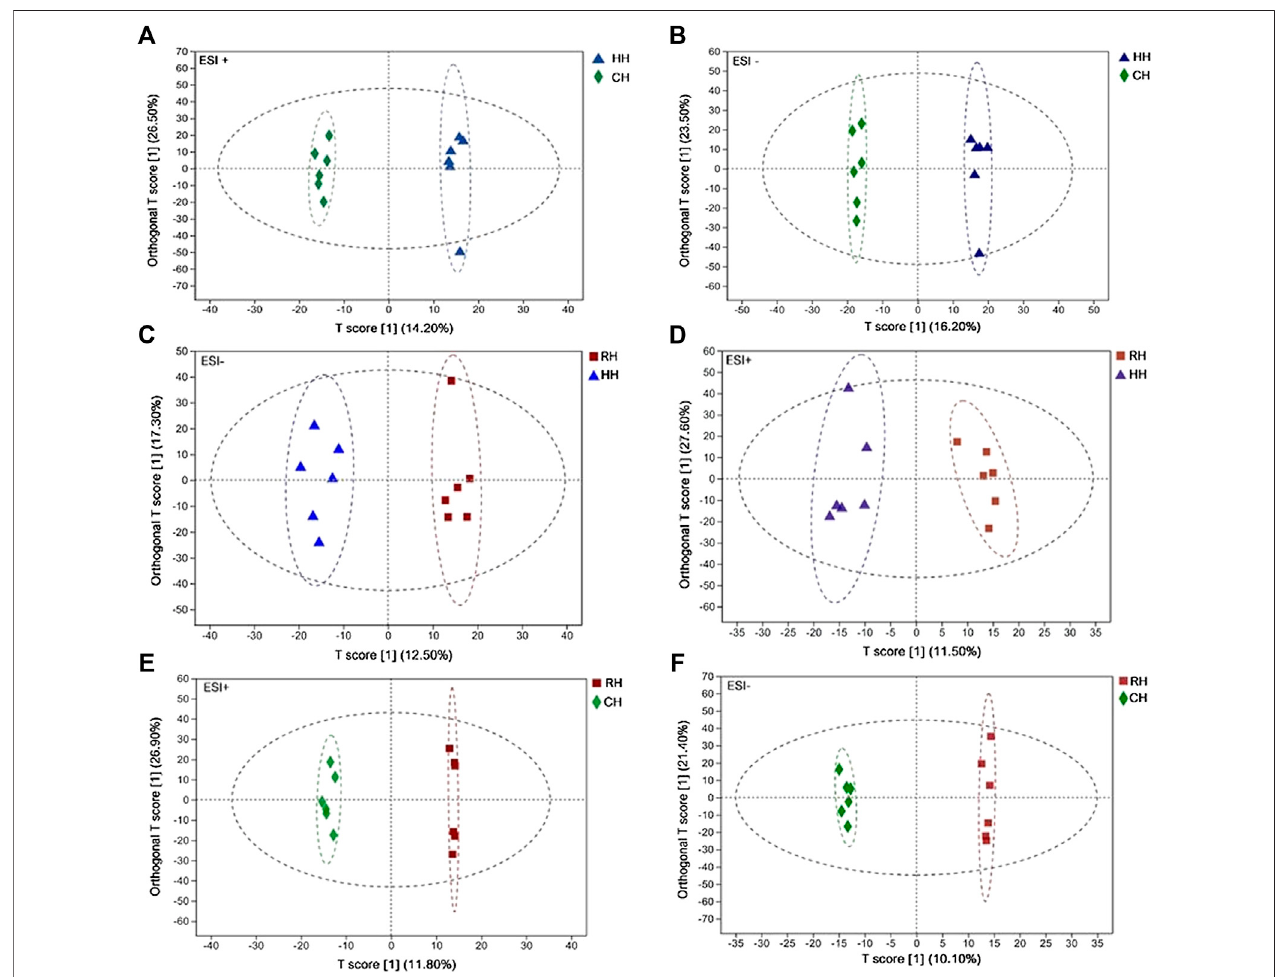
FIGURE 3 | OPLS-DA score scatter plot in HH vs. CH, RH vs. HH and RH vs. CH groups (ESI + , ESI − ) (A) : HH vs . CH (ESI + ); (B) : HH vs . CH (ESI − ); (C) : RH vs . HH (ESI + ); (D) : RH vs . HH (ESI − ); (E) : RH vs . CH (ESI + ); (F) : RH vs . CH (ESI −